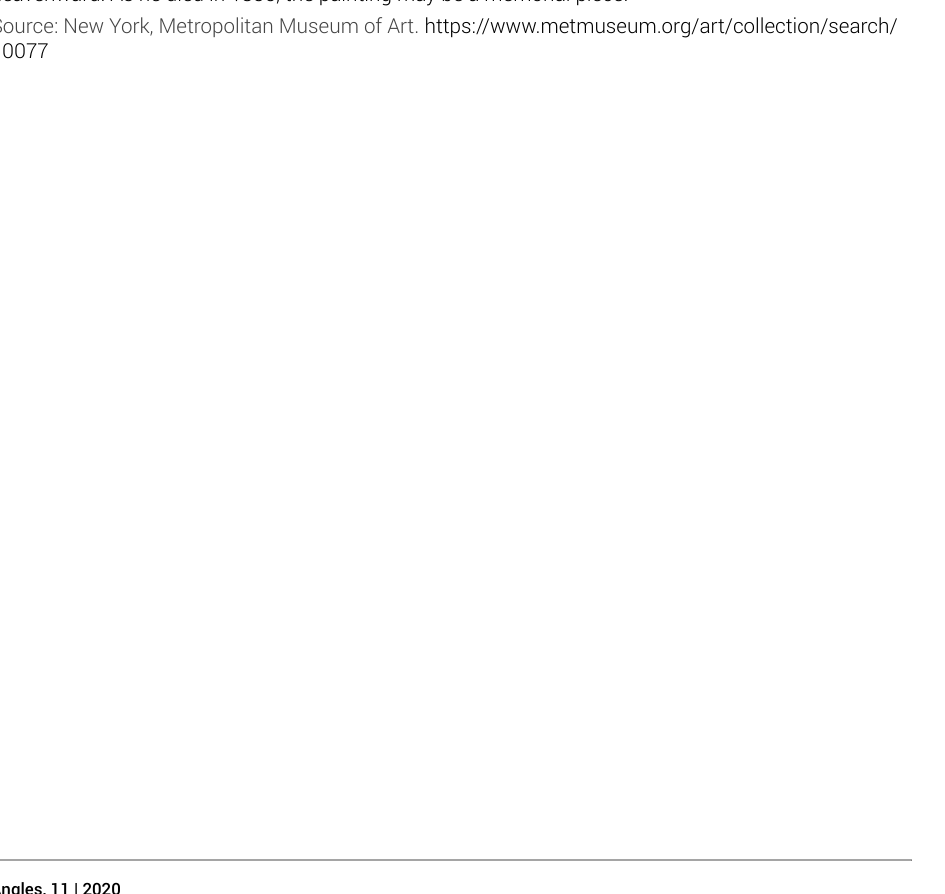
Here again children are at the centre of focus in this rather eerie indoor scene presenting a mother with her children playing “battledore and shuttlecock”. What seems to be a peaceful and quiet scene of domestic happiness actually begs for explanation. The children look very grave and while the oldest play the same game, the youngest one, Edward, with a hoop in his right hand, points his gaming stick heavenward. As he died in 1835, the painting may be a memorial